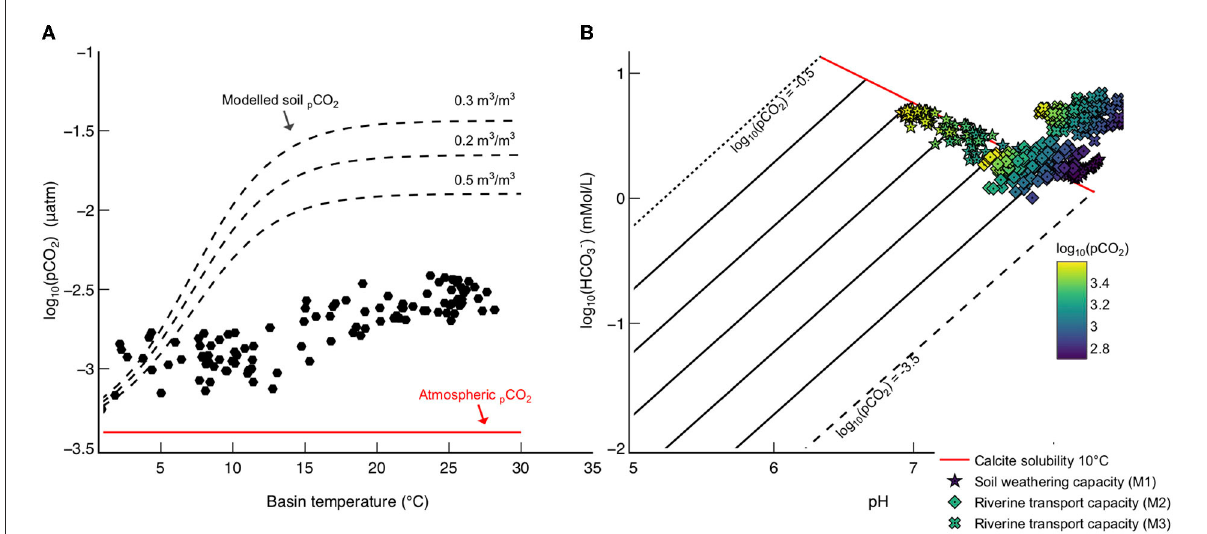
FIGURE3 (A) Difference in pCO 2 values between river waters (hexagonal-black points) transporting HCO – 3 , and soil waters weathering lime powder (dashed lines). Soil pCO 2 values are calculated using Equation 6 (Romero-Mujalli et al., 2019b), labels refer to soil water volume, river pCO 2 values are derived from Lauerwald et al. (2015). The difference between soil and river pCO 2 values are greatest at higher temperatures, i.e., tropical basins. The mean soil pore water volume for basins in this study is 0.25 m 3 m − 3 , which is derived from ESA soil moisture data. Atmospheric pCO 2 (red line) = -3.4. (B) Open system model for different pCO 2 solution paths at 10 ◦ C and initial pH = 5 (approximate value for rainwater). Modelled equilibrium soil weathering capacity (Model 1), equilibrium riverine transport (Model 2), and supersaturated riverine transport (Model 3) are